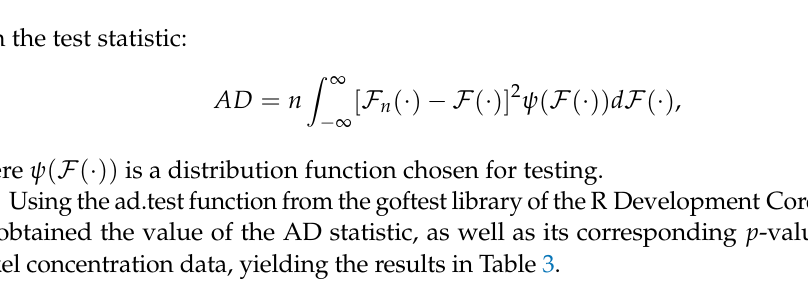
Table 3. Anderson–Darling (AD) statistics for the EEBLN, EBLN, LPN, LN, FBS, and SBS distributions.